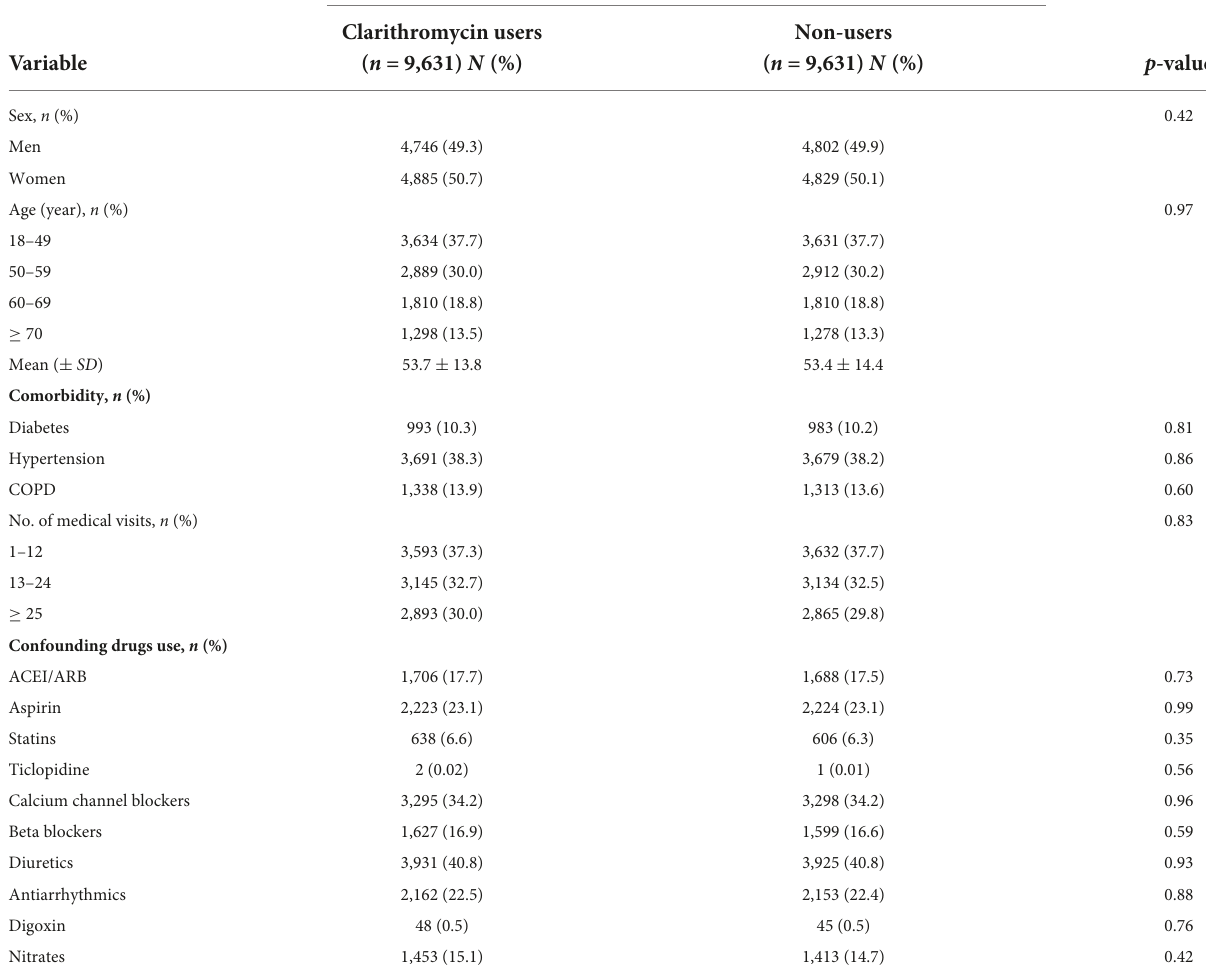
TABLE 1 Characteristics of study cohort by the use of